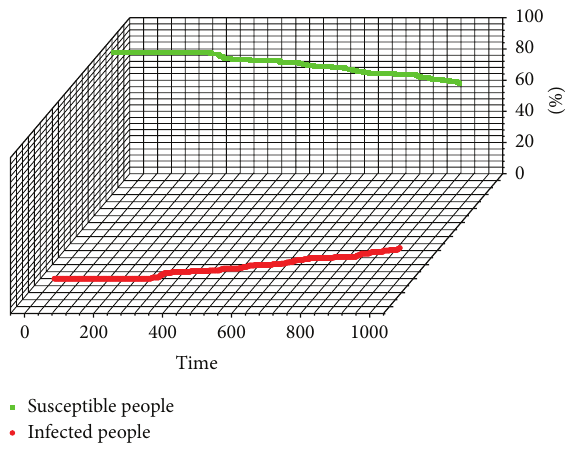
Figure 8: The epidemic status of the